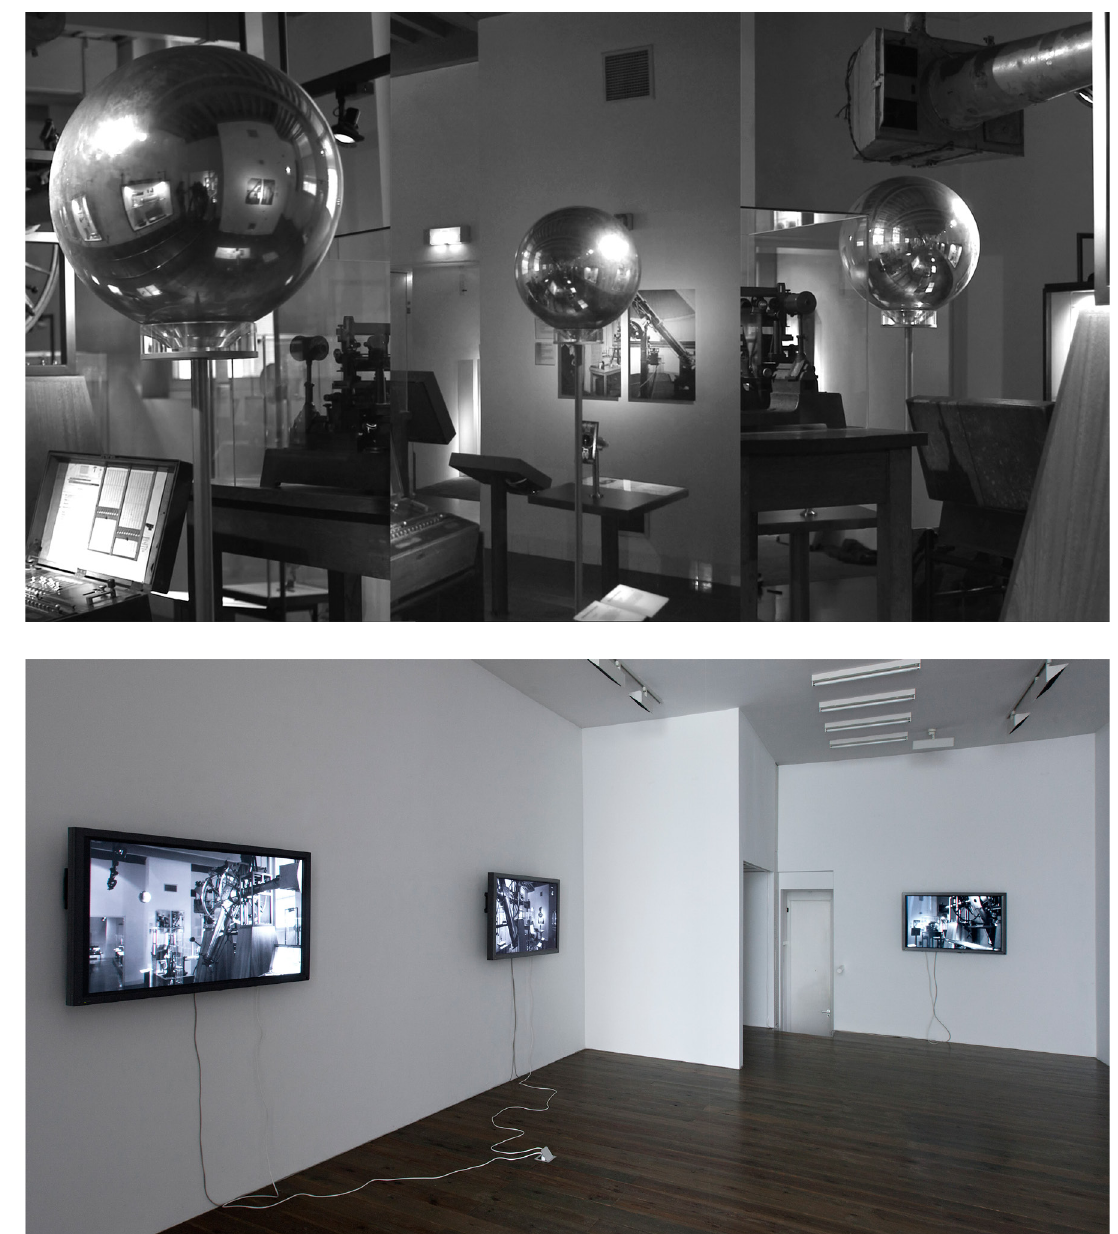
Figs. 1 and 2 Roos Theuws, Kitab Al Manazir, 2013, three-channel video installation. Photos: GJ.van Rooij